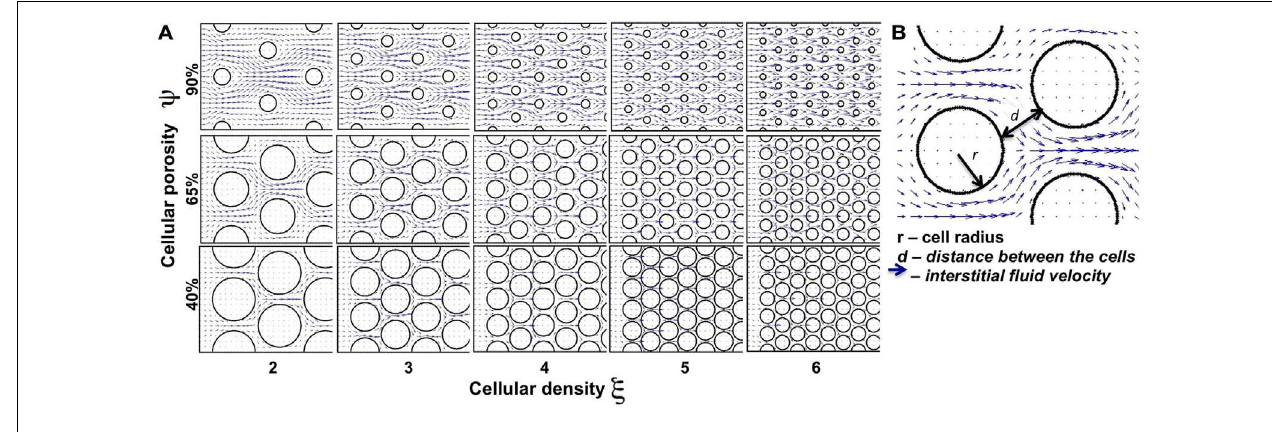
Tumor cells are represented by circles and the interstitial fluid velocity field initiated at the left edge of the domain is shown as blue arrows pointing in the direction of fluid flow. (B) The interstitial space is determined by the size ( r ) of the cells and distance ( d ) between the neighboring